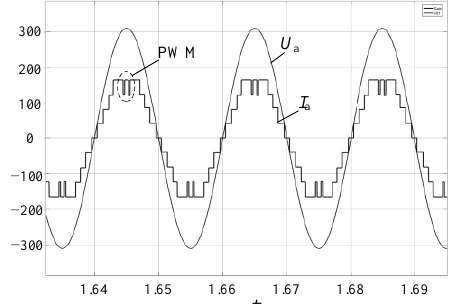
Fig. 16. Diagrams of the input current and voltage of phase A. 24-pulse converter is operating in the rectifier mode. In Fig. 17, the diagrams of the input current and voltage of phase A are shown when the 24-pulse converter is operating in the inverter mode. Fig. 14. 24-pulse rectifier with pulse-width modulation in inverter mode.